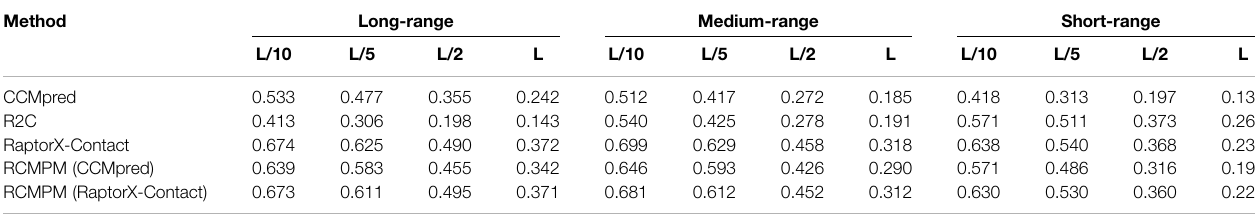
TABLE 2 | Contact map results by four different methods on the CASP10 testing dataset.